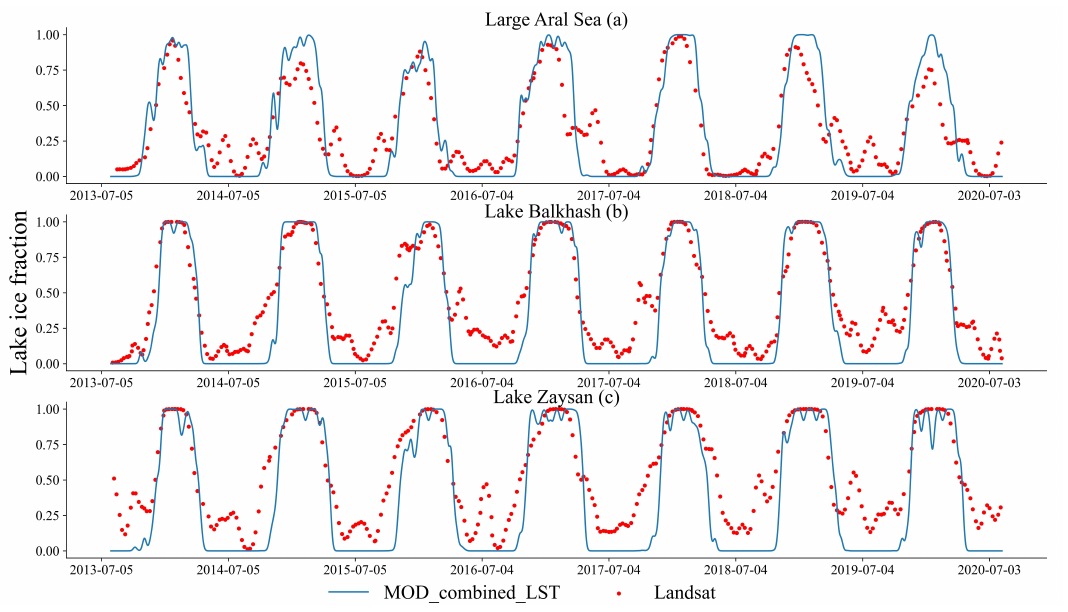
Figure 3. Time series of the water–ice fraction in the Large Aral Sea ( a ), Lake Balkhash ( b ), and Lake Zaysan ( c ) derived from the MODIS LST daily-combined image and Landsat8 from 2013 to 2020.